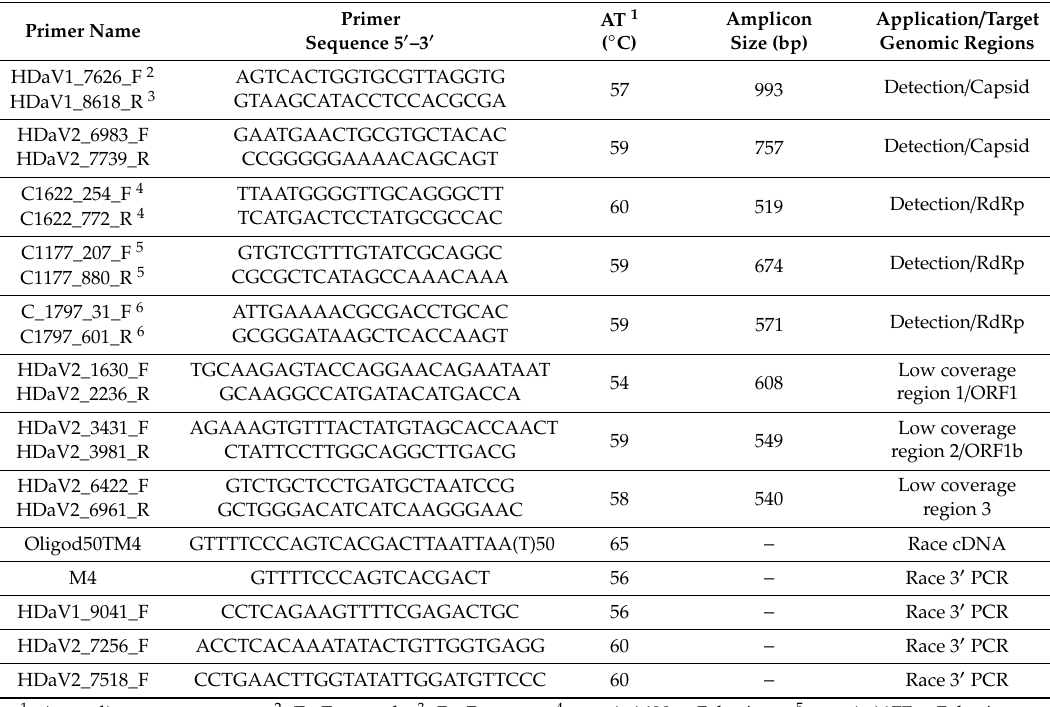
Table 1. Specific primers sequences used in PCR, RT-PCRs, and 3 (cid:48) RACE. Primer